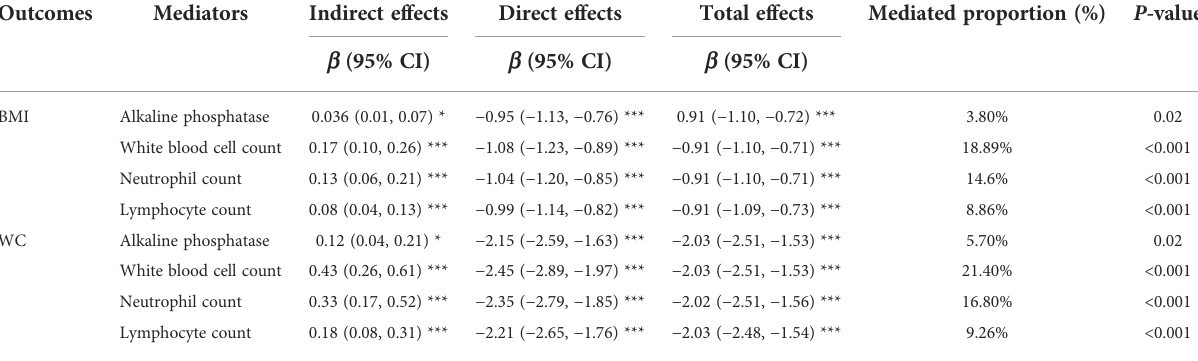
TABLE 5 The mediation effects of in fl ammatory markers on the association of log2-transformed HbEO with anthropometric parameters in adults.